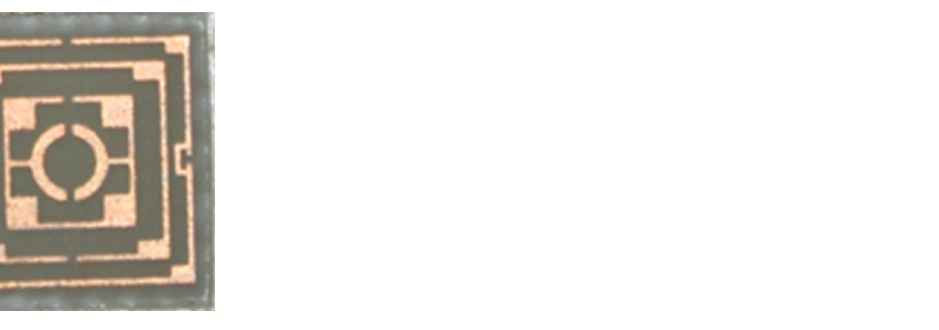
Figure 23. The fabricated prototype of the unit